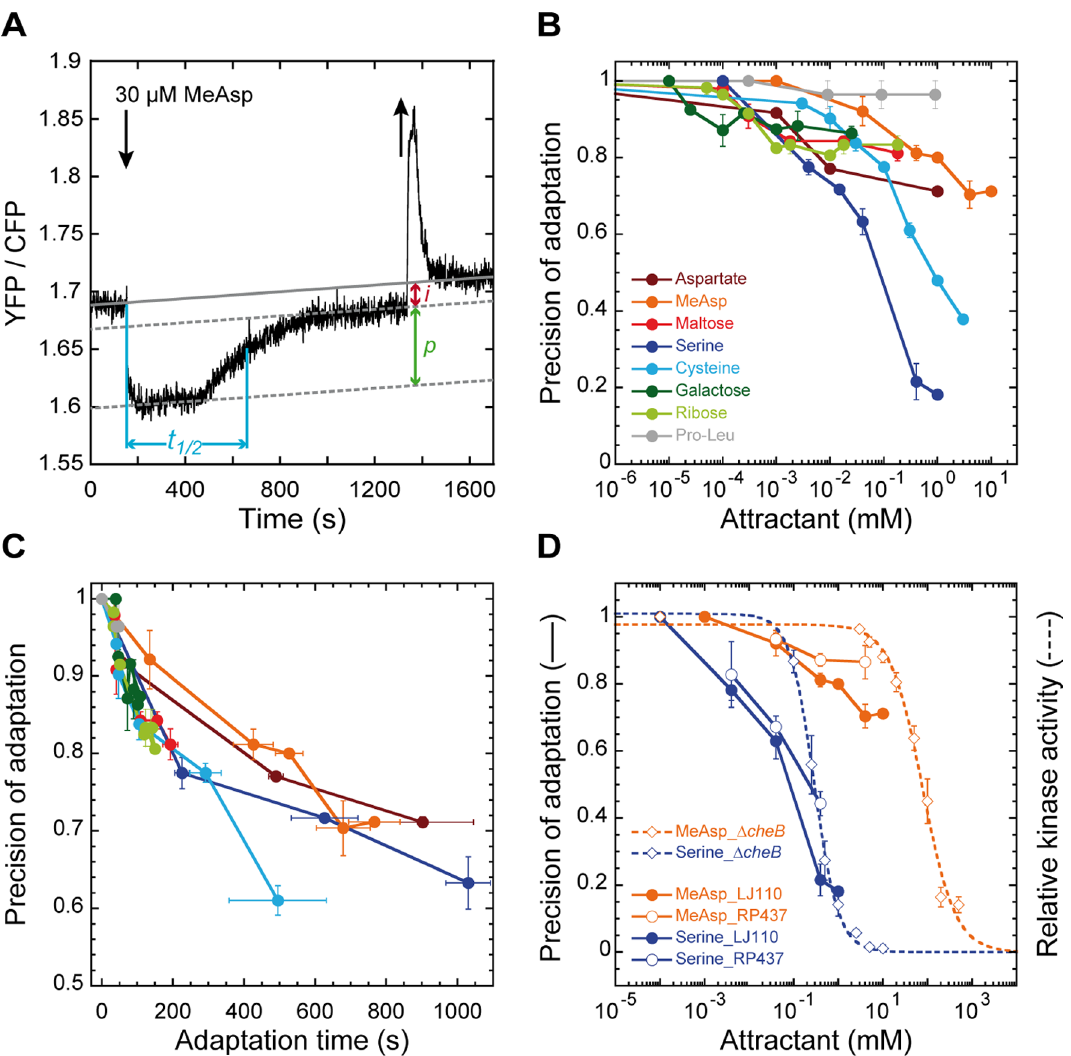
Figure 1. Precision of adaptation in wild-type cells. ( A ) Example FRET measurement of the pathway response. Cells expressing the CheY-YFP/ CheZ-CFP FRET pair, a reporter for kinase activity, were stimulated by step-like addition (down arrow) and subsequent removal (up arrow) of 30 m M MeAsp, a nearly saturating stimulus. Changes in kinase activity in response to addition of attractant were used to determine adaptation time ( t 1/2 ), defined as the time required to regain 50% of the initial loss in activity, and imprecision of adaptation ( i ), defined as the difference in the YFP/CFP ratio between cells adapted to buffer (interpolated grey solid line) and to a given attractant concentration (parallel dotted line below). Precision of adaptation ( p ), the fraction of kinase activity recovered in the presence of ambient ligand, was then obtained as 1 2 i , with 1 being the maximum possible precision (see Materials and Methods for details). The upward drift of the baseline is due to faster photobleaching of CFP compared to YFP. ( B ) Dependence of precision of adaptation on attractant concentration in wild-type strain SN1 [LJ110 D ( cheY cheZ )]. Values were normalized to the response of buffer-adapted cells to a saturating ligand concentration. Some data in (B) were replotted from [14]. Error bars here and throughout indicate standard errors for multiple measurements. ( C ) Dependence of precision of adaptation on adaptation time. ( D ) Comparison of precision of adaptation for MeAsp (orange symbols) and serine (blue symbols) in strains SN1 (closed circles) and VS104 [RP437 D ( cheY cheZ ), open circles] with dose-response curves of cheB strain VS124 [RP437 D ( cheB cheY cheZ )] for steps of MeAsp or serine (open diamonds). Relative kinase activity was calculated as described previously [16,17] and fitted by a multisite Hill equation [17].